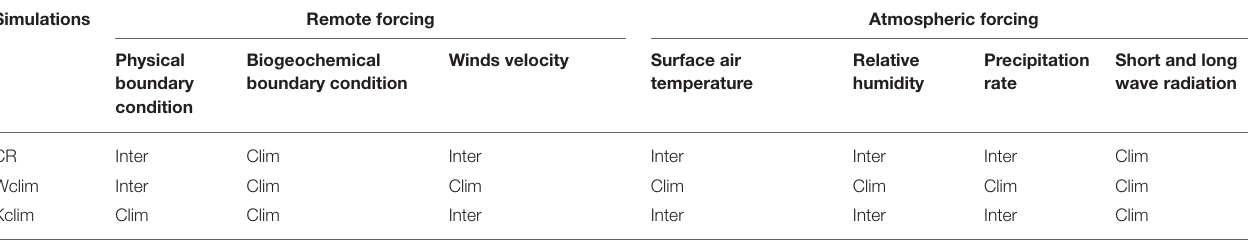
TABLE 1 | Characteristics of the model